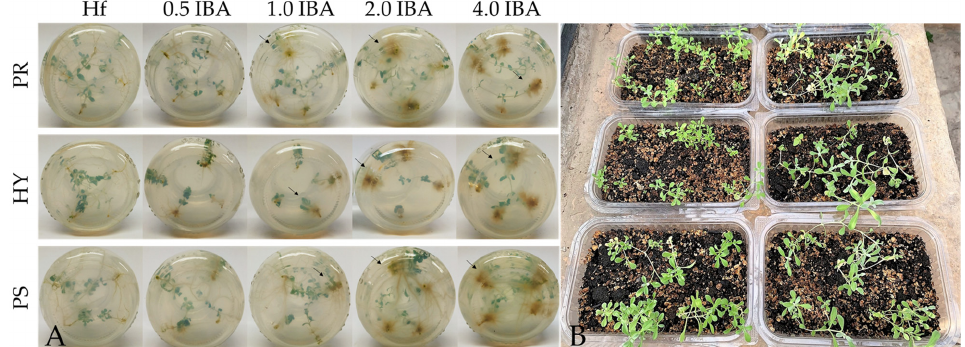
Figure 5. ( A ) In vitro rooting of three C. candidissimum populations: Parnitha (PR), Hymettus (HY) and Parnassos (PS). Induction of roots took place on half strength Murashige and Skoog media, either hormone-free (Hf) or supplemented with indole-3-butyric acid (IBA) at 0.5, 1.0, 2.0 and 4.0 mg L − 1 ; arrows show hairy roots on various IBA concentrations. ( B ) Acclimatisation phase: 21 day old plants showing vigorous growth in 500 mL